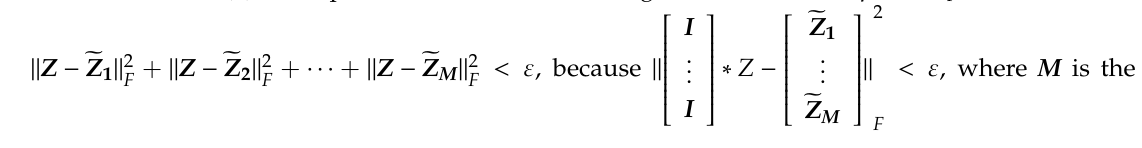
Figure 2. Schematic diagram of a single local window and multiple local windows and the corresponding filters ( N = 5): ( a ) single local window; ( b ) multiple local windows.